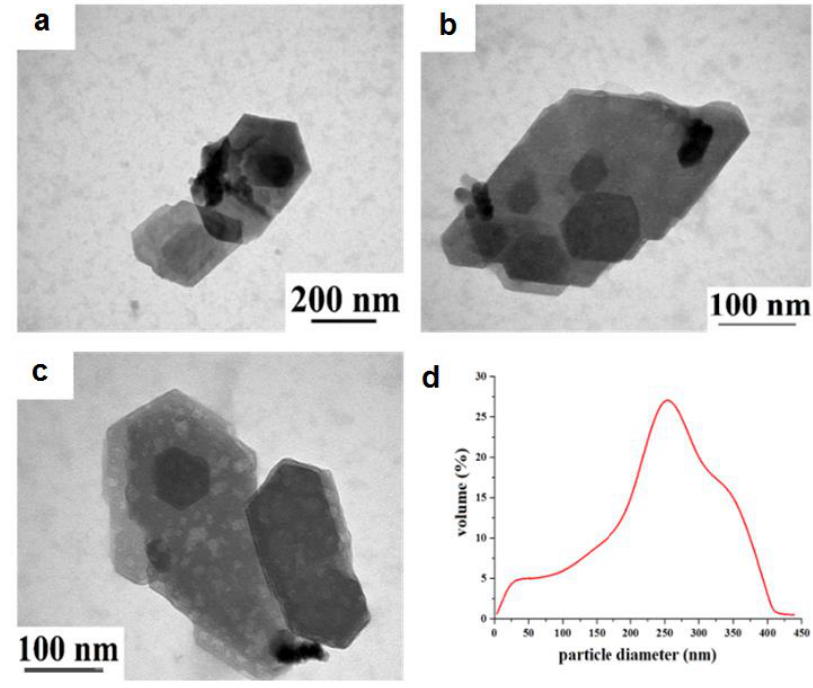
Figure 11. ( a – c ) TEM images and ( d ) particle size distribution curve of sample 3a .